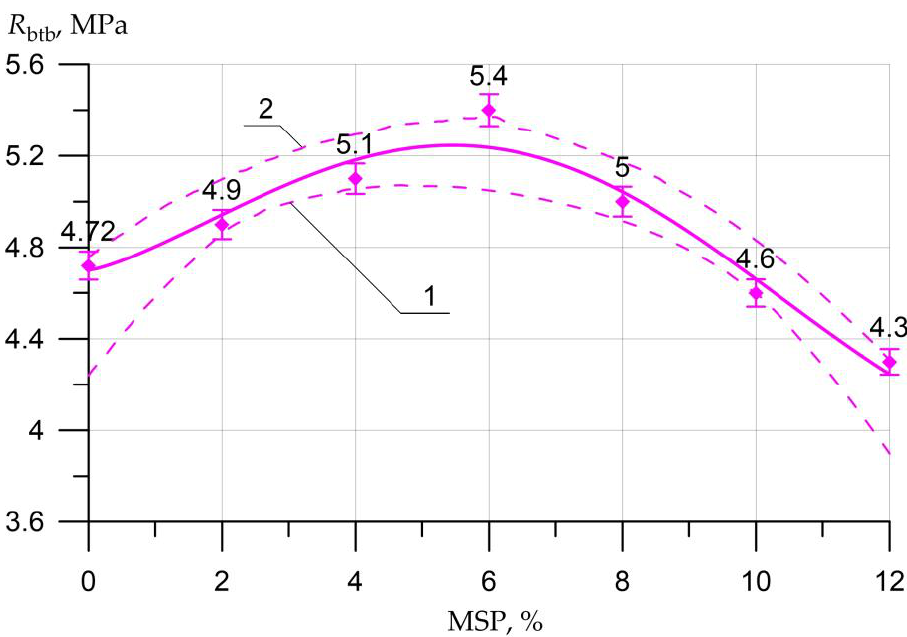
Figure 7. Flexural TS R btb of concrete as a function of the amount of MSP: 1—lower confidence level; 2—upper confidence level.